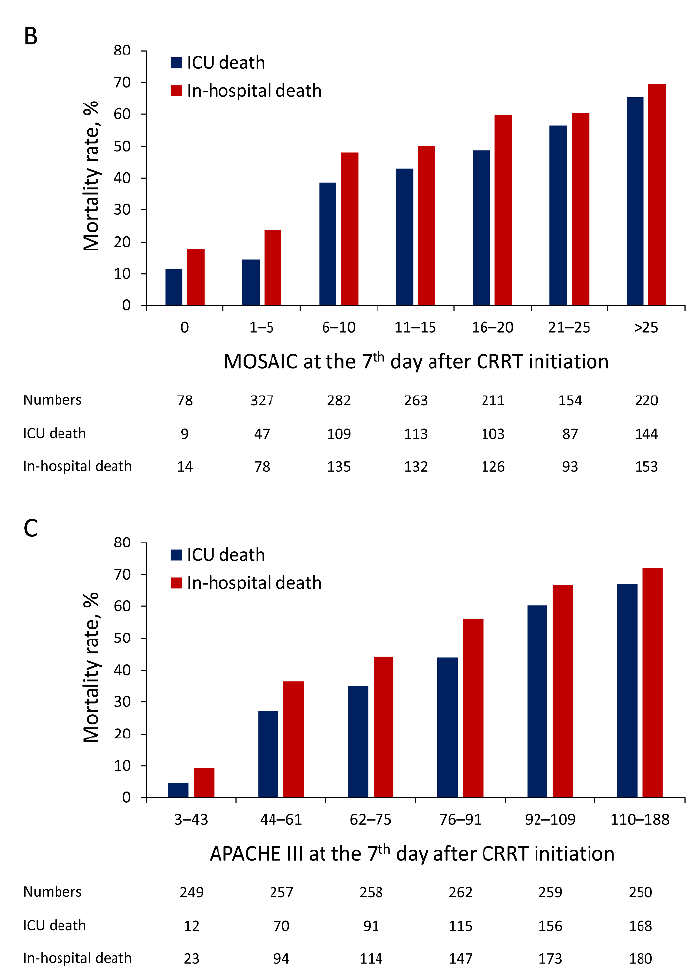
Figure 2. Distribution of SOFA ( A ), MOSAIC ( B ), and APACHE III ( C ) scores at day 7 after CRRT initiation and their relationship with ICU mortality and in-hospital mortality in the whole population. SOFA, Sequential Organ Failure Assessment; APACHE, Acute Physiology and Chronic Health Evaluation; MOSAIC, Mortality Scoring system for AKI with CRRT.